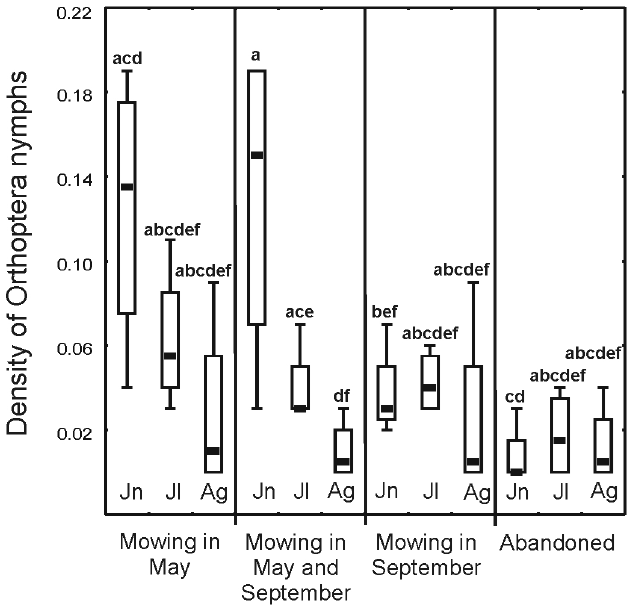
Figrue 4. Box-plots (median values with minimum, maximum and ±SE) of species richness, adult density (specimen/m 2 ) and Shannon diversity of orthopterans in four treatment types (mow- ing once a year in May; mowing twice a year in May and Septem- ber; mowing once a year in September; abandoned) in June (Jn), July (Jl) and August (Ag). Significant (p<0.05) differences detected by Mann-Whitney U test are indicated by different letters.